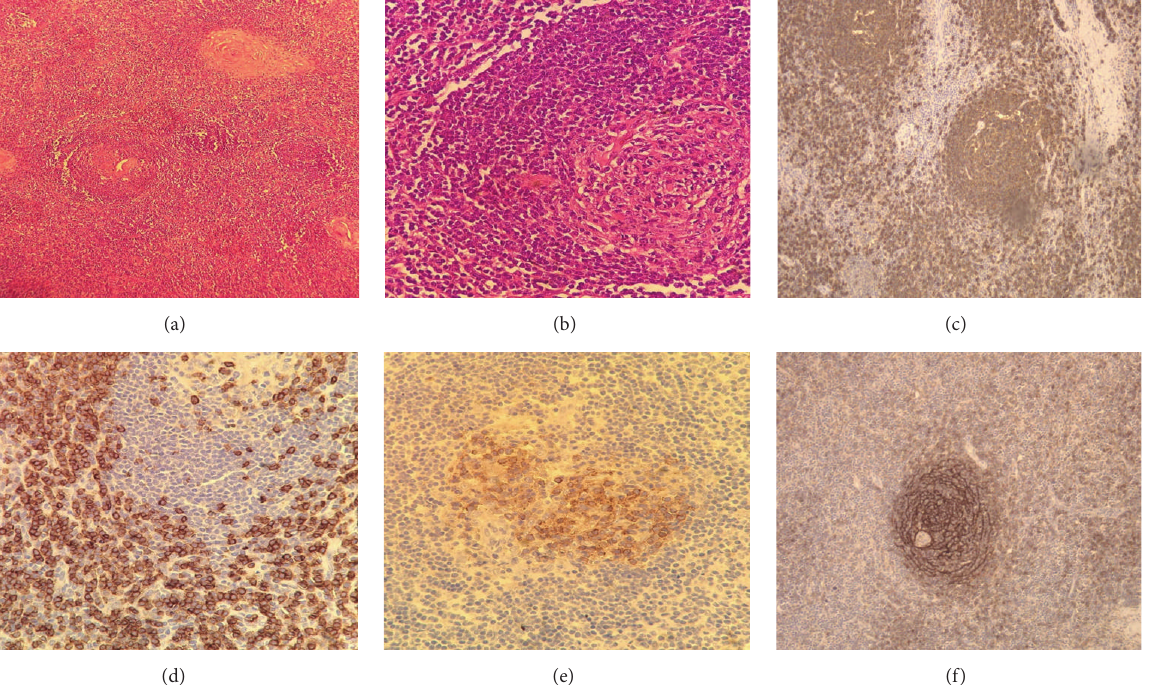
Figure 2: (a) Histology of the tissue showed proliferation of lymphoid follicles (H&E, 20x). (b) Lymph node with lymphoid cells in an “onion skin”patternwithahyalinecenter(H&E,40x).(c–f)ImmunohistochemicalstainingforCD20,CD3,CD10,andCD21positivitydemonstrated follicular